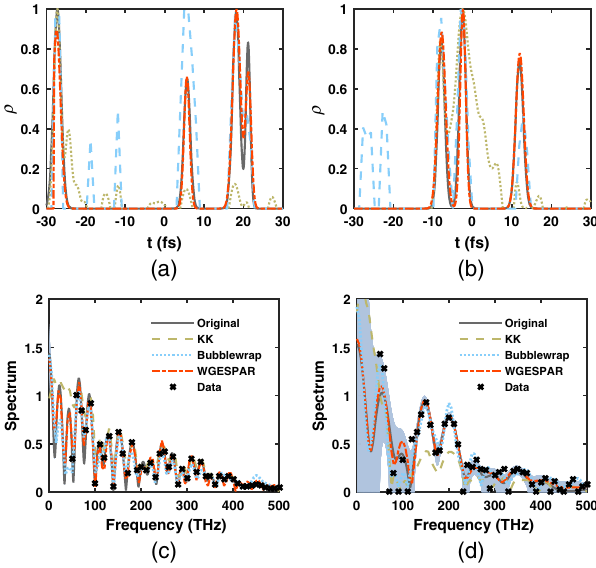
FIG. 2. The comparison of the WGESPAR, KK, and Bubble- wrap algorithms for a current reconstruction with large support (a),(c) or noisy spectra (b),(d). The beam current profiles (a),(b) and the spectra (c),(d) are provided for the original current profile (gray line) and the results reconstructed by the WGESPAR algorithm (red dashed line), the KK algorithm (yellow dashed line), and the Bubblewrap algorithm (blue dotted line), respec- tively. The cross spots are sampled from the original spectrum, and the blue shading represents the uncertainty with 10% Gaussian noise in the wavelength domain.